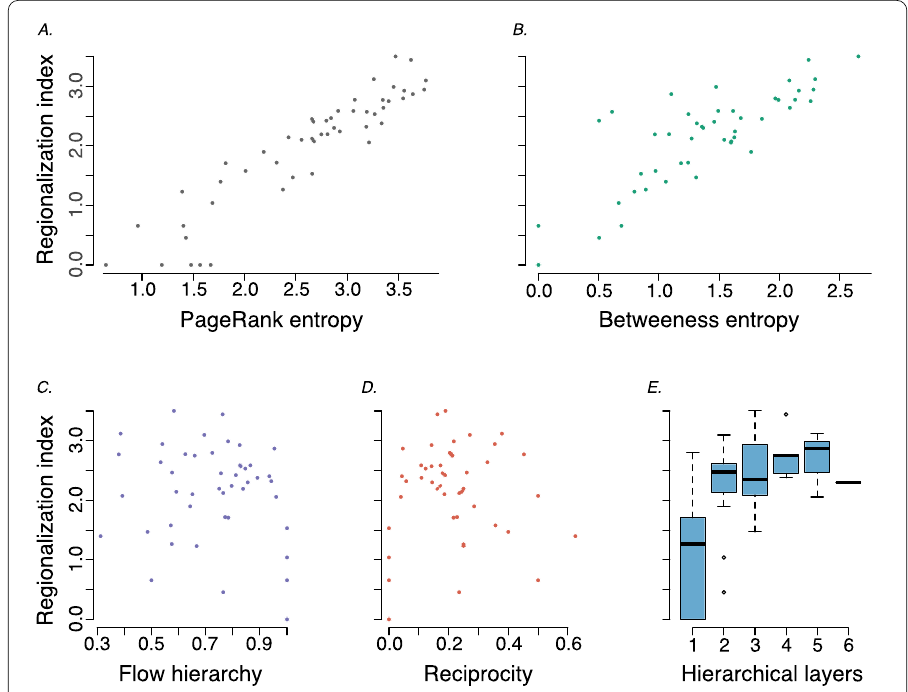
Figure 4 The association between the regionalization index and the community-level. ( A ) PageRank entropy, ( B ) betweenness centrality entropy, ( C ) flow hierarchy, ( D ) reciprocity, and ( E ) number of hierarchical layers. The regionalization index was positively associated with the community-level entropy of PageRank ( R 2 = 0.85; p < 0.001) and betweenness centrality ( R 2 = 0.76; p < 0.001); however, regionalization was negatively associated with flow hierarchy ( R 2 = 0.10; p < 0.014), not linearly correlated with reciprocity ( R 2 = 0.05; p = 0.07), and only weakly associated with the number of hierarchical layers (the mean regionalization index was significantly lower in communities with only a single hierarchical layer; ANOVA: degrees of freedom = 5; F value = 7.245; p < 0.001; Tukey HSD test, with a correction for multiple comparisons, was used post-doc to determine which group means were different)